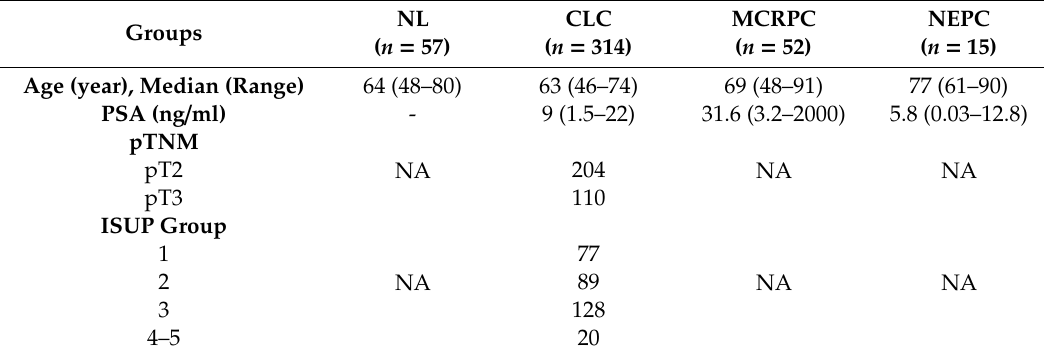
Table 2. Patients and tissues